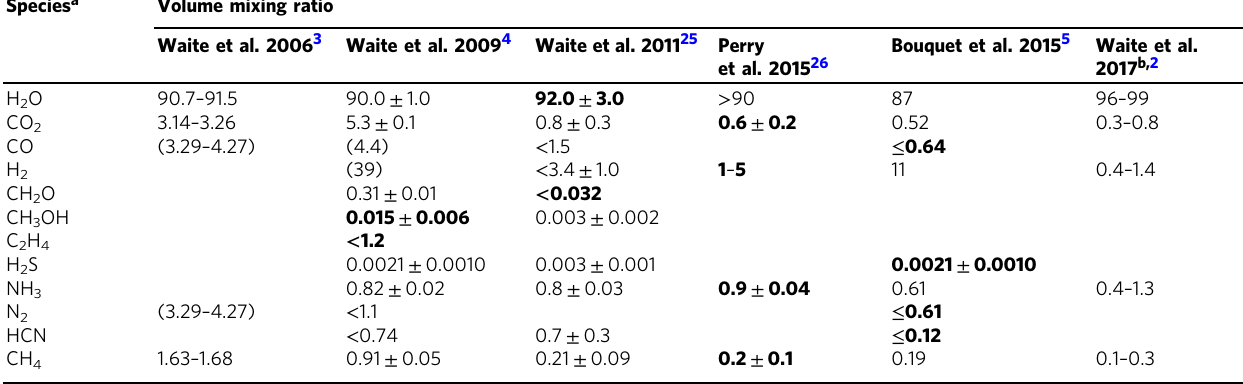
Table 1 Compilation of Cassini ’ s INMS data on Enceladus ’ plume composition over the last decade Species a Volume mixing ratio